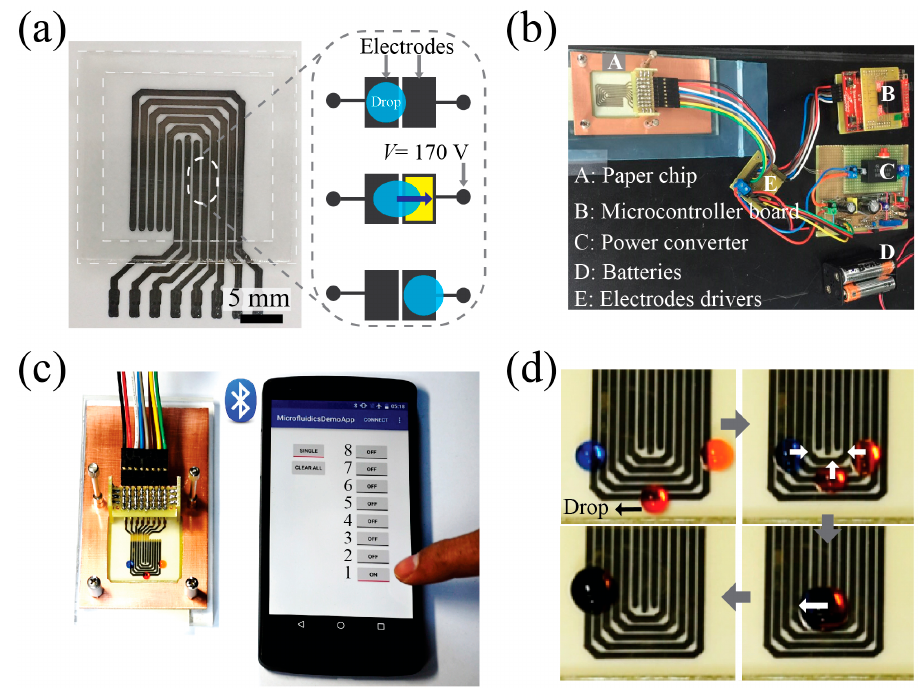
Figure 5. Demonstration of drop actuation on an affordable paper-DMF chip: ( a ) a printed paper chip and (inset) drop actuation scheme and ( b ) the chip connected to a power switching device. ( c ) A smartphone App being run through wireless Bluetooth, and ( d ) three digital drops initially at rest being simultaneously transported (top) to merge into one drop at the center and then being transported to the left (bottom).